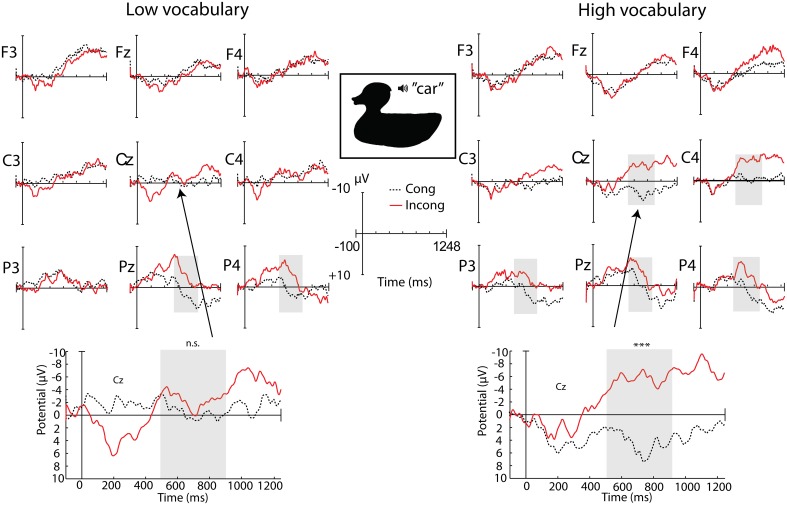
ERP topography for the congruous and incongruous silhouette conditions at 20 months, displayed for the two vocabulary groups separately. The time window with a significant effect of congruity in separate group analyses is shaded in gray (***p < 0.01).